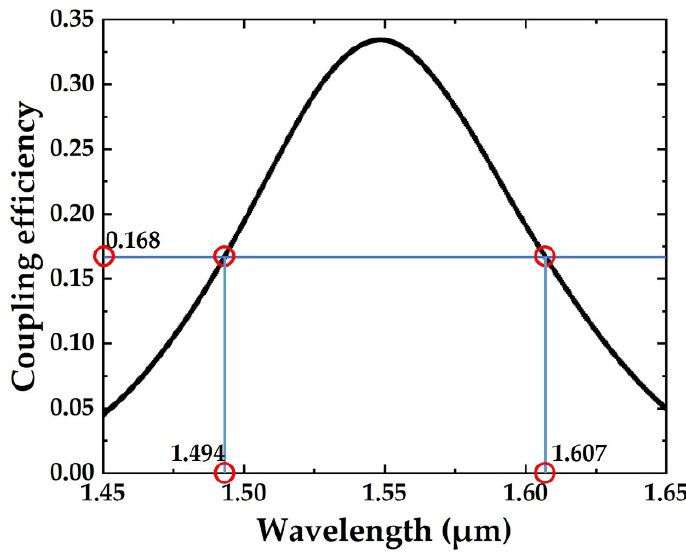
Figure 2. Coupling efficiency as a function of wavelength.